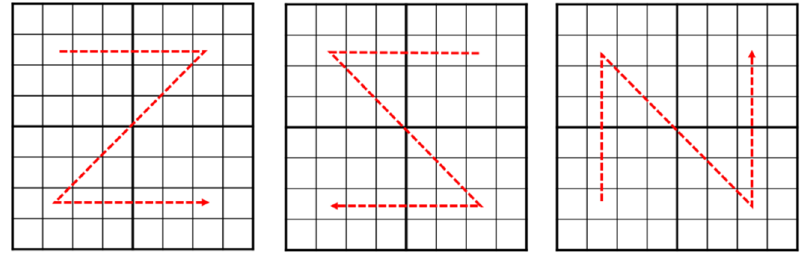
Figure 4. Three different coding orders when the coding tree unit (CTU) has an 8 × 8 size and it is split into 4 × 4 CUs: Above-left to bottom-right (left), above-right to bottom-left (middle), and bottom-left to above-right (right).